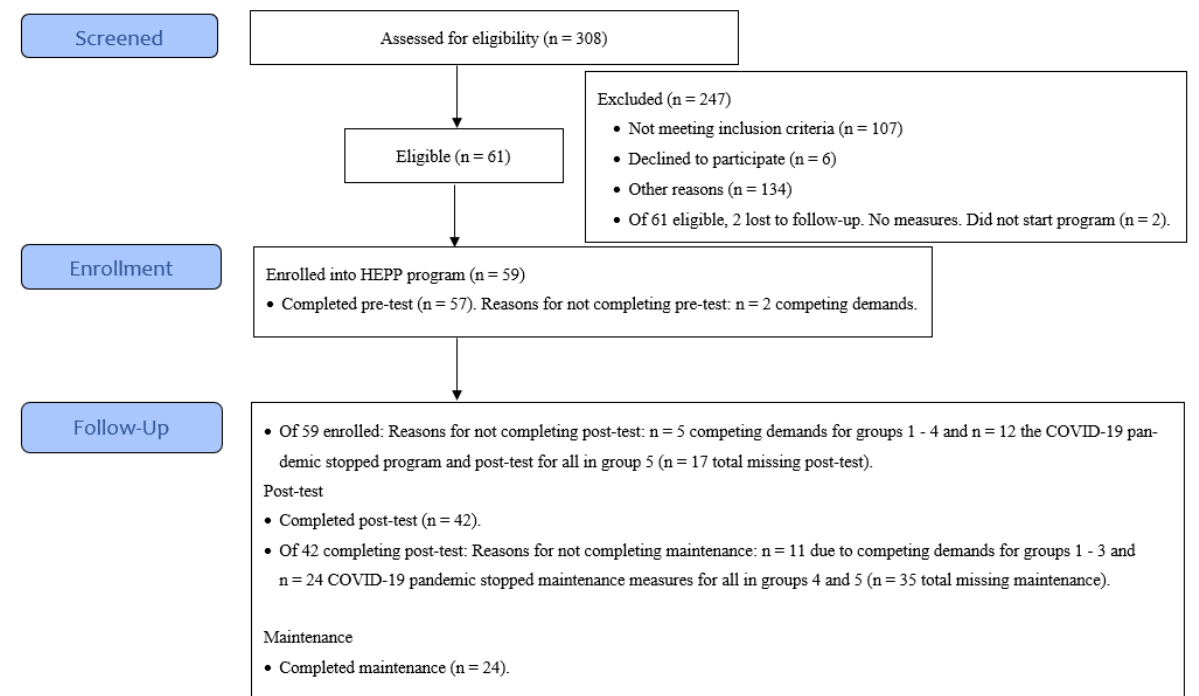
Figure 2. Participant recruitment and enrollment for the HEPP program. Figure shows flow of partic- ipants from recruitment through enrollment and follow-up (post-test and maintenance